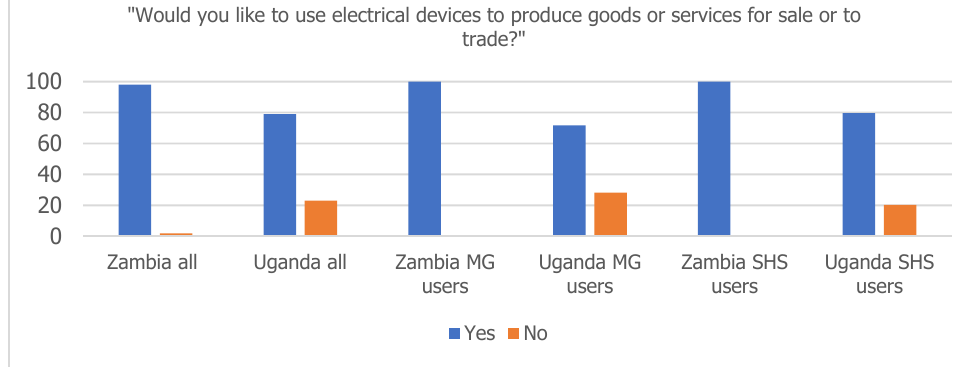
Figure A4. Desired energy connection, Southern Zambia, N = 50, Responses in %.